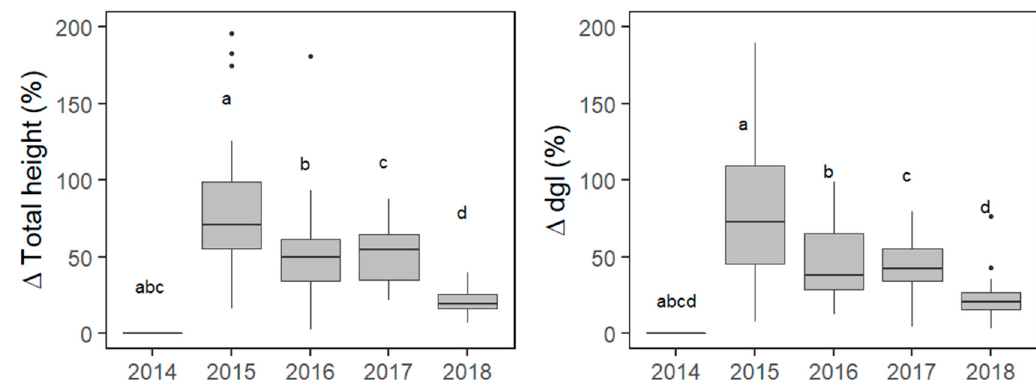
Figure 6. The annual rate of change in total height and diameter at ground level (dgl) of 33 native species from 2014 to 2018. In the boxplots, the thick line shows the median, the box extends to the upper and lower quartiles, the thin vertical lines indicate the nominal range and the small circles indicate points which lie outside of the nominal range. For a given graph, different letters (a, b, c, and d) denote significant differences among clustered species ( p < 0.05) using the Tukey’s HSD test.